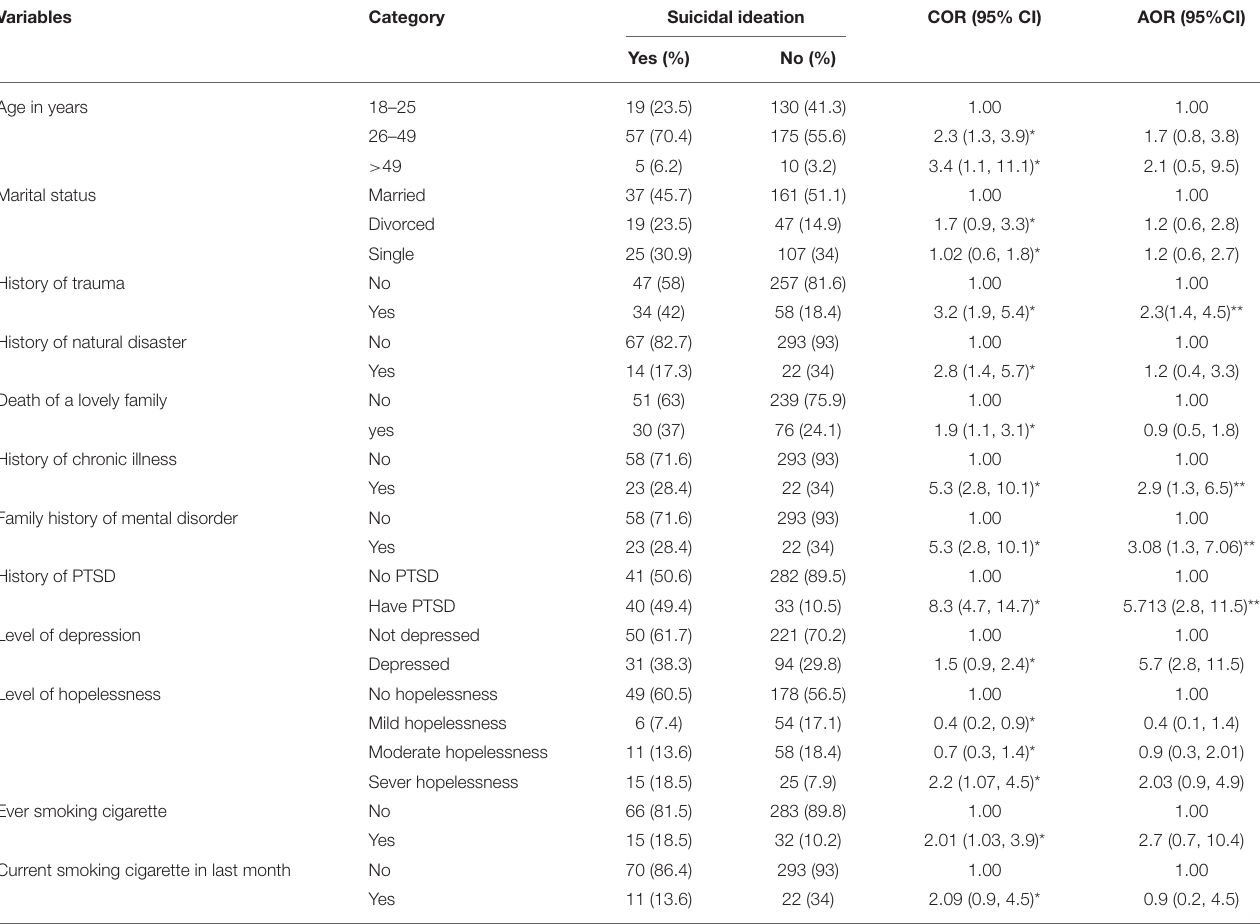
TABLE 4 | Determinants of suicidal ideation, at Mai Aini, Eritrean refugee camps, Tigray, northern Ethiopia, 2020.